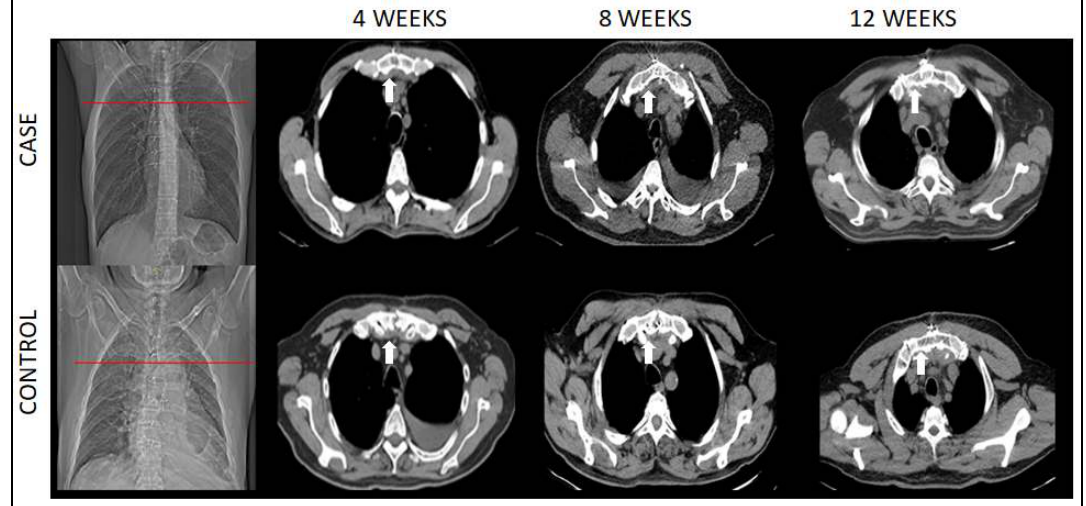
Figure 2: From computed axial tomography of one patient from cases group and other from control group. Axial Tomographic images show medullar and bone continuity at 4 and 8 weeks in case above, compared with control (Below) only with medullar continuity at 8 weeks; at 12 weeks callus bone was present in patients of both groups.